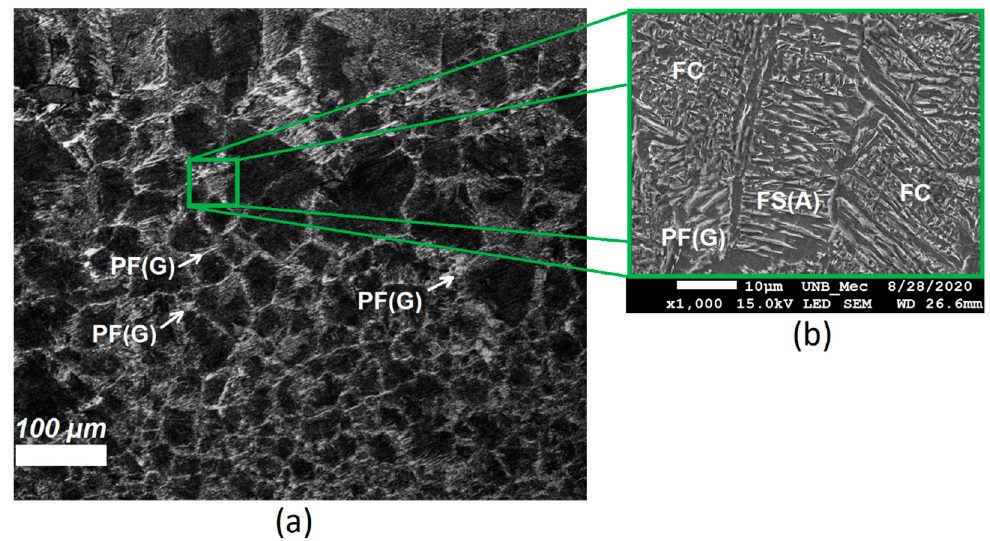
Figure 7. Microstructure of CGHAZ in ( a ) optical microscopy at 200 × and ( b ) SEM at 1000 × showing the formation of grain boundary ferrite (PF(G)), Ferrite with Aligned Second phase (FS(A)) and aggregate ferrite-carbide (FC). Etching: Nital 5%.